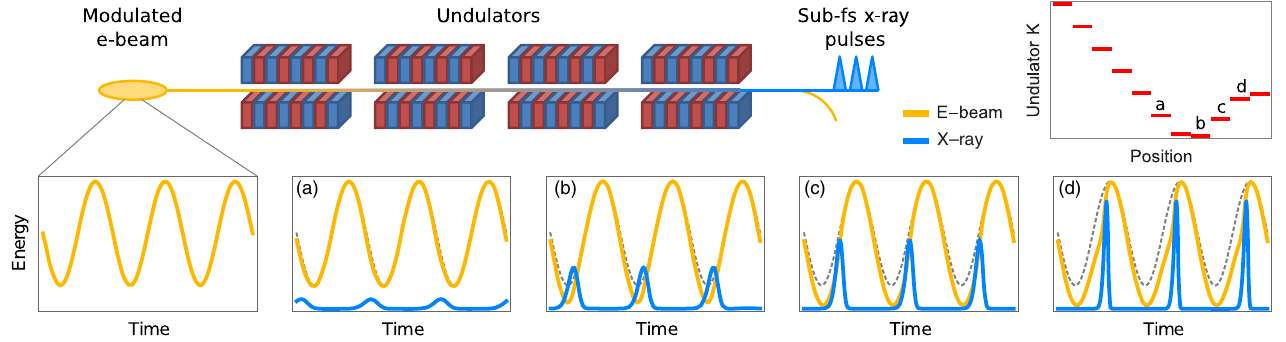
FIG. 1. Diagram of the chirp-taper setup along with a cartoon of the temporal dynamics. The bottom row of plots depicts the electron beam longitudinal phase space (yellow curves) and x-ray power (blue curves) at various points along the undulator line (labeled), depicted top right. After generating a single spike of radiation via a linear chirp-taper section, the undulators are varied to maintain resonance as the radiation advances over the electron